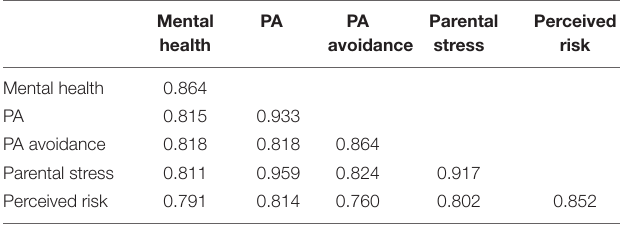
TABLE 3 | Fornell-Larcker criterion.